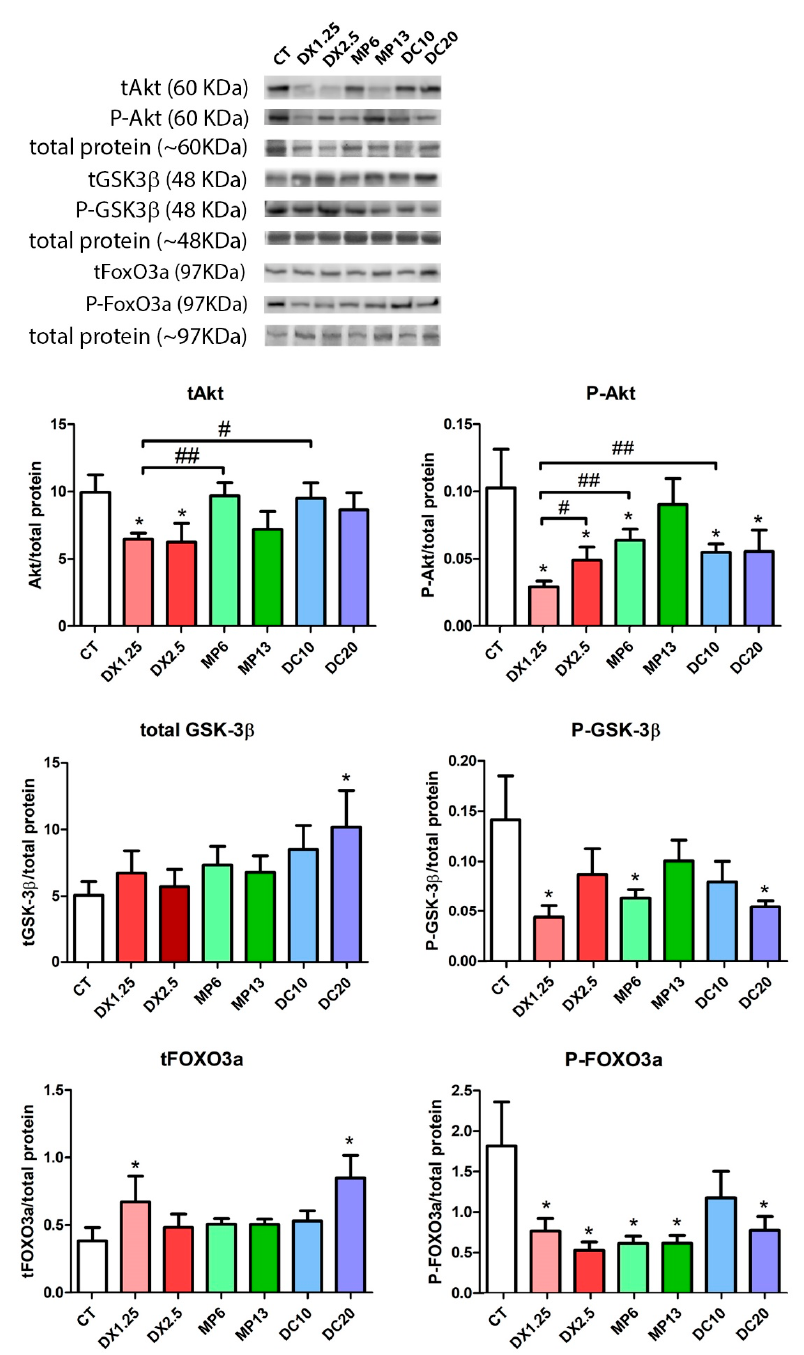
Figure 3. Western blotting analysis of the IGF-1 pathway after administration of different glucocorticoids. (*) represents the statistical difference in comparison to the CT and (#) represents statistical difference between groups. Legend: * or # = P < 0.05; ## = P < 0.01 ( n per group: CT = 10, DX1.25 = 9, DX2.5 = 8, DC10 = 10, DC20 = 10, MP13 = 8, MP6 =